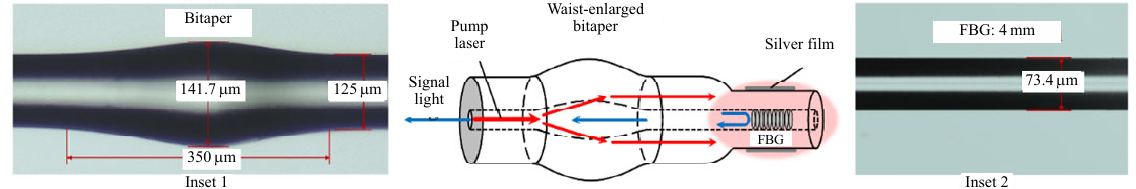
Fig. 1 Schematic diagram of the proposed optical fiber anemometer. Inset 1: micrograph of the waist-enlarged fiber bitaper and Inset 2: micrograph of the etched